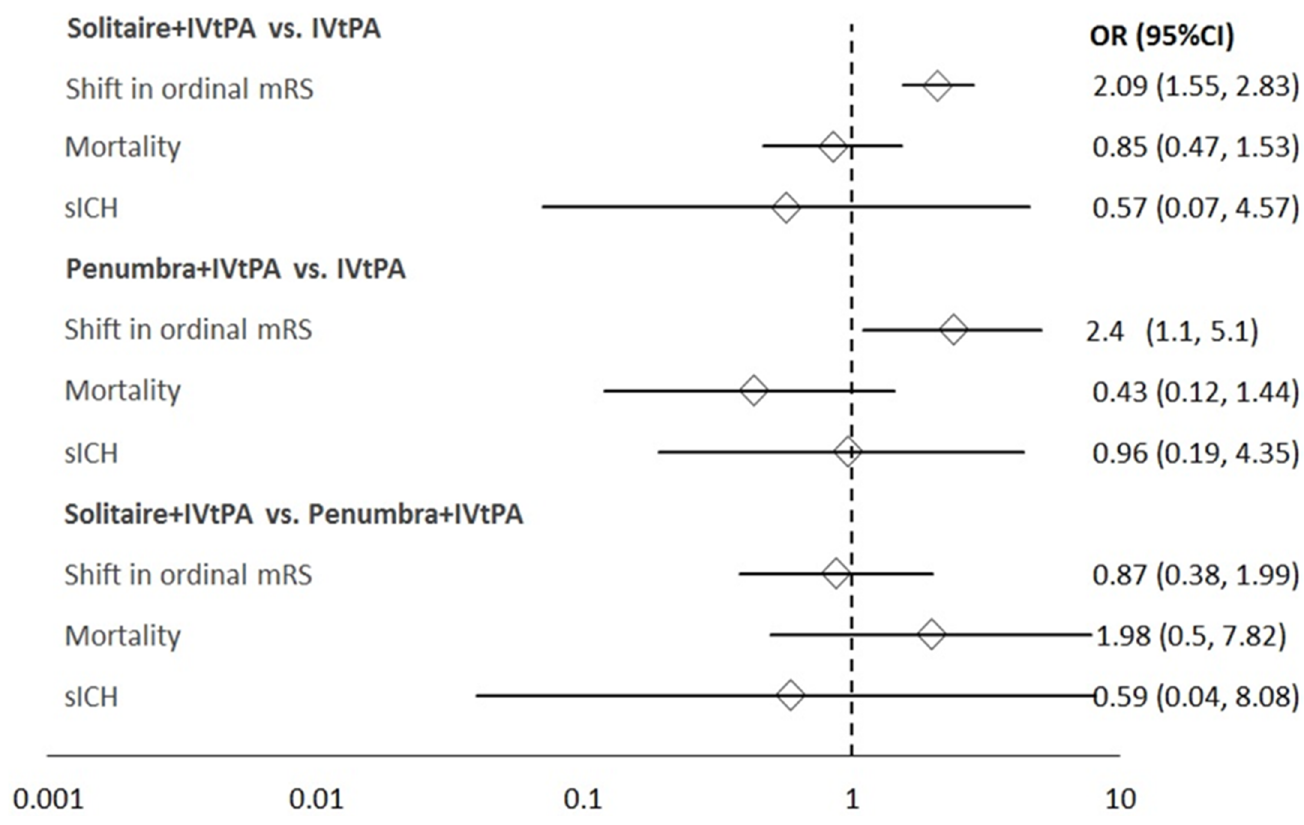
Fig 3. Sensitivity analysis: Results from the traditional and indirect treatment comparison meta-analyses incorporating the REVASCAT Trial. CI = 95% Confidence Interval; IVtPA = Intravenous Tissue Plasminogen Activator; mRS = modified Rankin Score; OR = Odds Ratio; REVASCAT = Thrombectomy within 8 Hours after Symptom Onset in Ischemic Stroke; sICH = Symptomatic Intracranial Hemorrhage.